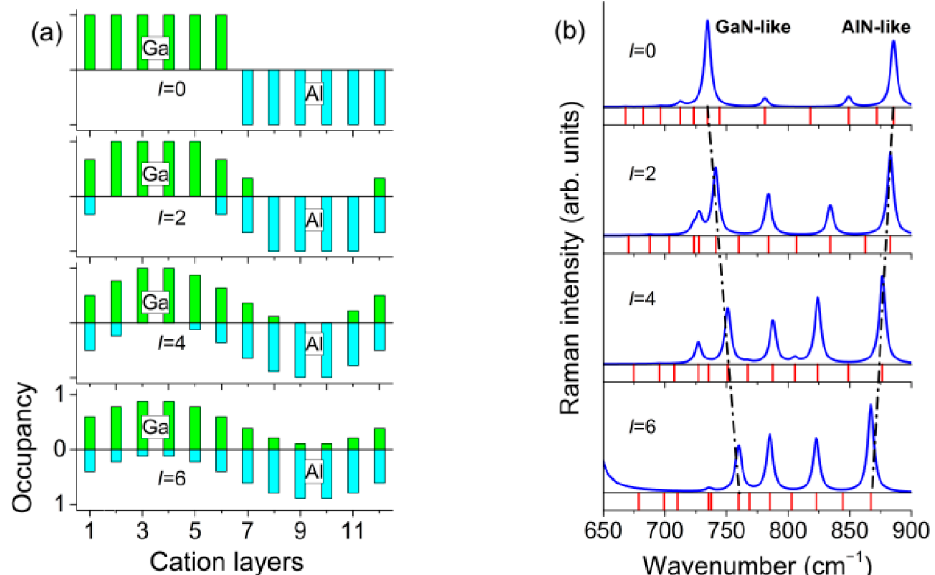
Figure 3. Cation concentration profiles of (GaN) 6 /(AlN) 6 SLs with different degrees of interface diffusion ( a ). 𝑧(𝑥𝑥)𝑧̅ Raman spectra of (GaN) 6 /(AlN) 6 SLs calculated within the REI model (blue lines) and the frequency distribution of A 1 (LO) modes (red lines) ( b ).